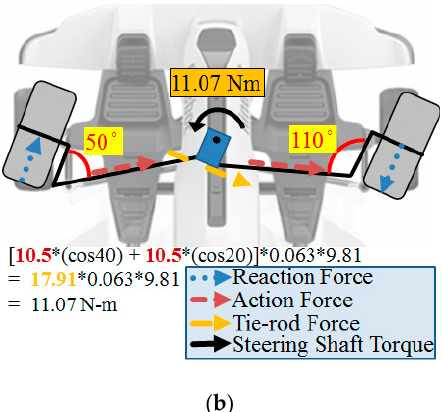
Figure 5. Schematic configuration of the steer-by-wire system by ideal design: ( a ) neutral position; ( b ) extreme position. Table 1. Specification of the steering shaft torque.